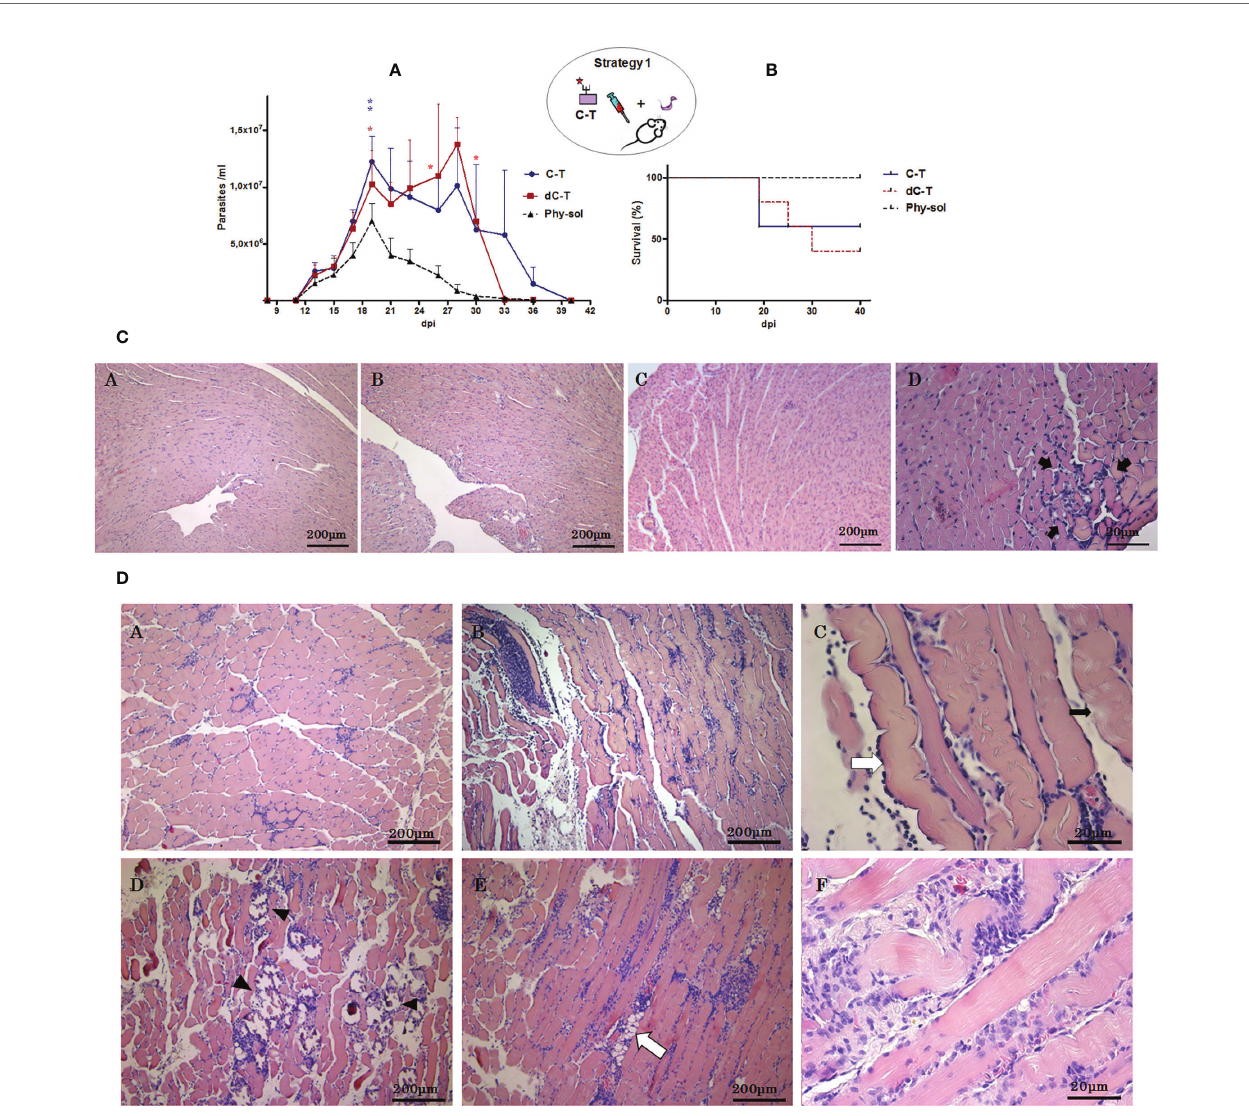
FIGURE 3 | Effects of C-T sulfotopes on parasitemia, survival, and tissue pathogenicity of BALB/c mice sublethally challenged with T. cruzi . (A) Parasitemia (parasite number/ml of peripheral blood). (B) Survival percentage (%) from control, C-T IM , and dC-T IM ( n = 5 mice per group) was recorded after the sublethal challenge with a dose of 2 x 10 3 blood trypomastigotes of T. cruzi , Tul 2 strain. Error bars indicate SD of the means. The days in which deaths were registered were marked in the curve with asterisks (*), in red and blue color. Blue lines represent C-T IM ; red lines, dC-T IM ; and grey dotted lines, Phy-Sol control group. Histopathologic alterations of cardiac (C) and skeletal muscle (D) tissues from nonimmunized control, C-T IM , and dC-T IM , postsublethal challenge by T. cruzi . (C) Optical microphotographs of cardiac muscle tissue transversal sections stained with hematoxylin/eosin obtained from nonimmunized control (A), dC-T IM (B), and C-T IM (C, D); 45 dpi. In (D), a lymphoplasmacytic in fl ammatory in fi ltrate focus is shown with greatest detail between arrows. (D) Optical microphotographs of sections from skeletal muscle tissue stained with hematoxylin/eosin obtained from nonimmunized control (A), C-T IM (B), and dC-T IM (D). [(A, B, D): ×10]. Longitudinal section of skeletal muscle fi bers of C-T IM (×40) (C), indicated with a white arrow is an edematous muscle fi ber and with black arrow lyses foci of the muscle fi ber. In the skeletal muscle tissue from dC- T IM , dystrophic calci fi cations (arrow tip) (D) and lipid degeneration (E) (white arrow) can be observed; (D) and (E) at ×10. At 40 x magni fi cation, a diffused severe lymphoplasmacytic in fl ammatory in fi ltrate and lyses foci (F) in dC-T IM can be observed. The oval scheme in the upper part of the fi gure represents strategy